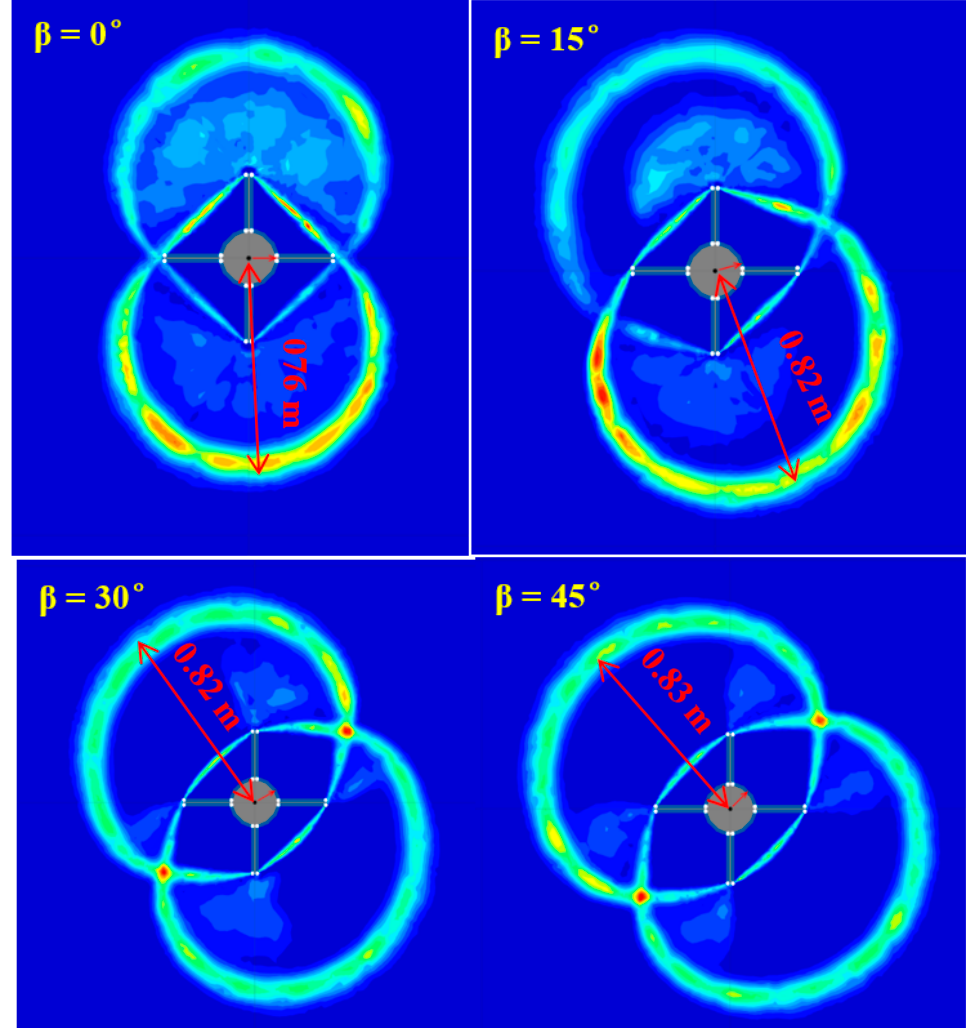
Figure 16. Effect of the different lateral-load directions on the shear plastic zone of the soil around the four-wing pile when pile–soil interaction coefficient a = 0.4 and wing–diameter ratio D e /B w = 3.